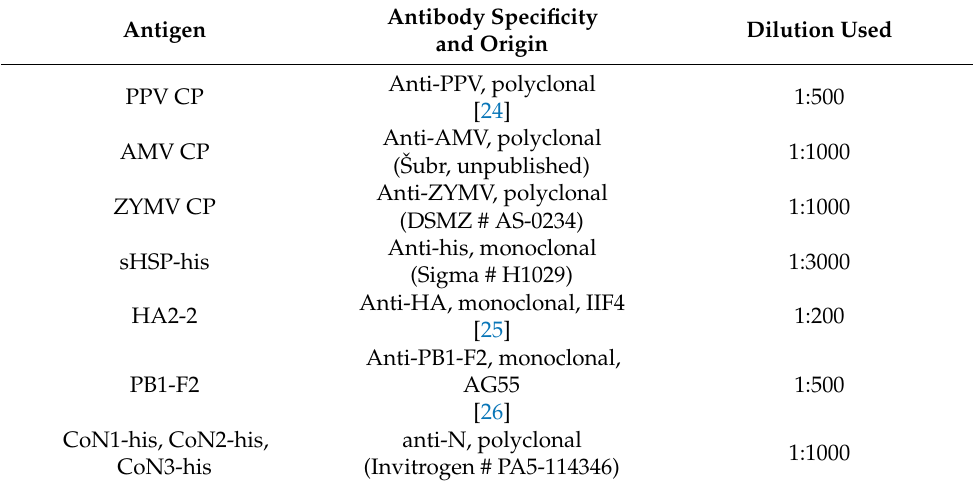
Table 2. Antibodies used for the detection of PPV-CP and expressed polypeptides.